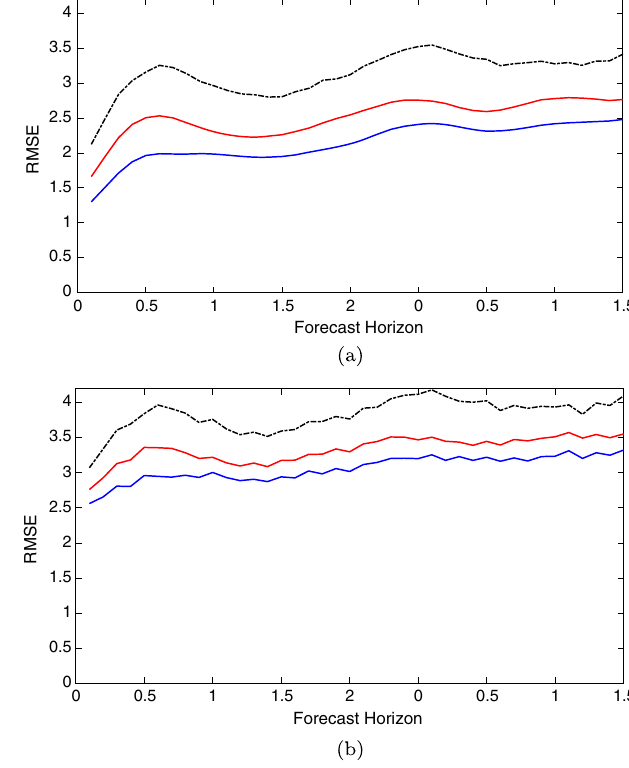
FIG. 7. Results of forecasting the x 1 node in a five-dimensional Lorenz-96 system when the training data are affected by 60% noise. Results averaged over 2500 realizations. Forecast error calculated with respect to (a) the non-noisy truth and (b) the noisy truth. Even in this higher-dimensional system, we see that use of the Kalman-Takens filter to filter the training data results in improved forecasting capability (solid red curve) as compared to forecasting without filtering (dotted black curve). The forecast based on Kalman-Takens initial conditions compares well to the same Takens-based forecast method using initial conditions from the parametric filter (solid blue